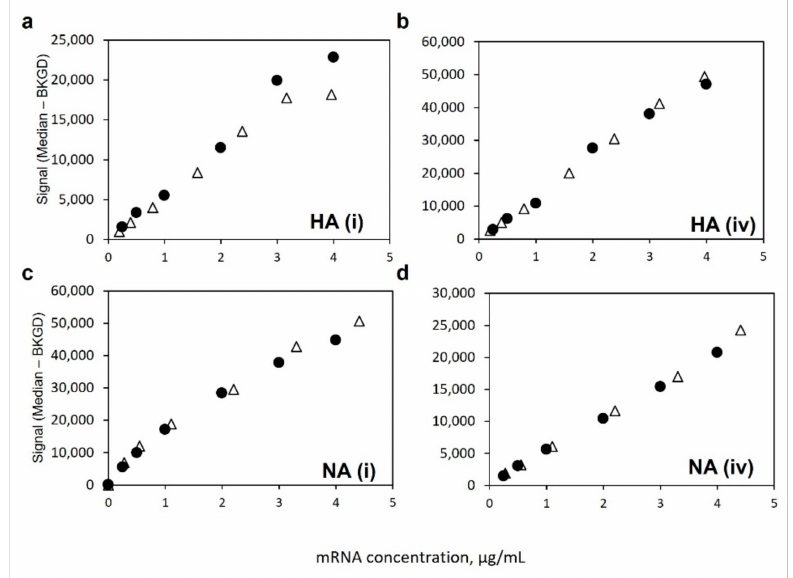
Figure 7. Similarity of response for bivalent LNP-encapsulated mRNA ( ∆ ) and naked mRNA ( • ) 8-point dilution series using polyT oligo detection label for HA mRNA using ( a ) HA(i) coding region capture, ( b ) HA(iv) coding region capture, and for NA mRNA using ( c ) NA(i) coding region capture, and ( d ) NA(iv) coding region capture. Table 3. Accuracy and Precision of LNP-encapsulated mRNA. Accuracy Precision Capture Oligo (% Recovery) (% of RSD of Measured Conc.)